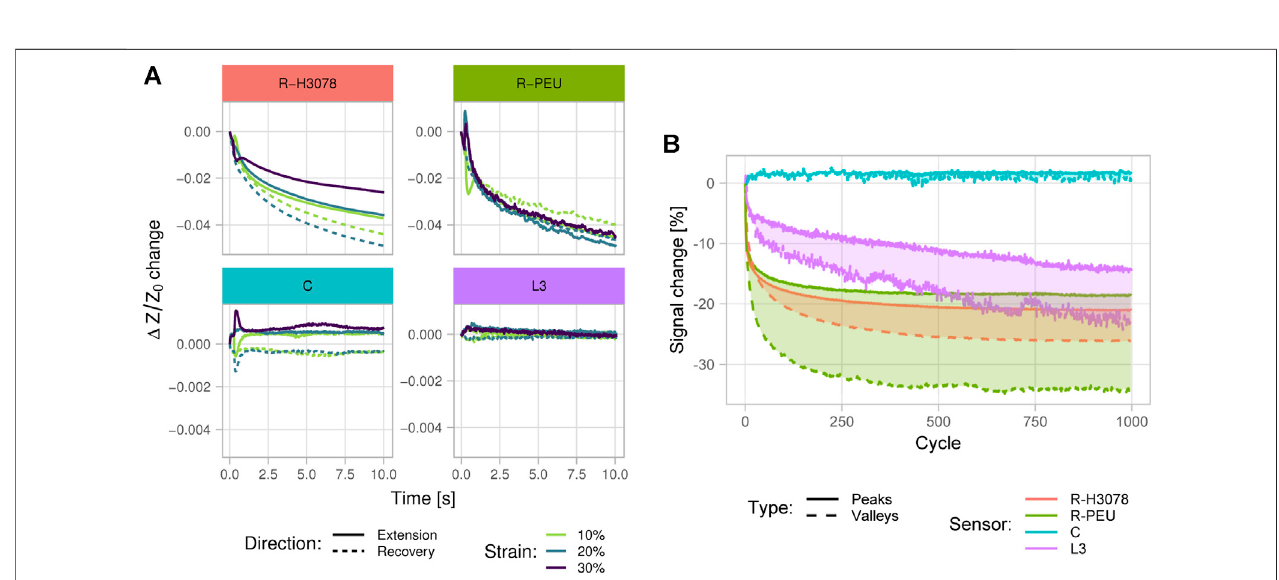
FIGURE 6 | Static (A) and dynamic (B) drift in the sensors. (A) Change in sensor signal reading from baseline over a 10 s hold at three strain magnitudes. For increased detail despite a lower sensitivity, the vertical scale of the non-resistive sensors (bottom) is enhanced by a factor of 10. Note that the small transient spike seen around 0.5 s is an artifact that was due to a correction from the UTM positioning algorithm. (B) Sensor signal drift over 1,000 sinusoidal strain cycles. Solid lines indicate the percentage change in signal peaks and dashed lines indicate the percentage change in signal valleys relative to the fi rst cycle.